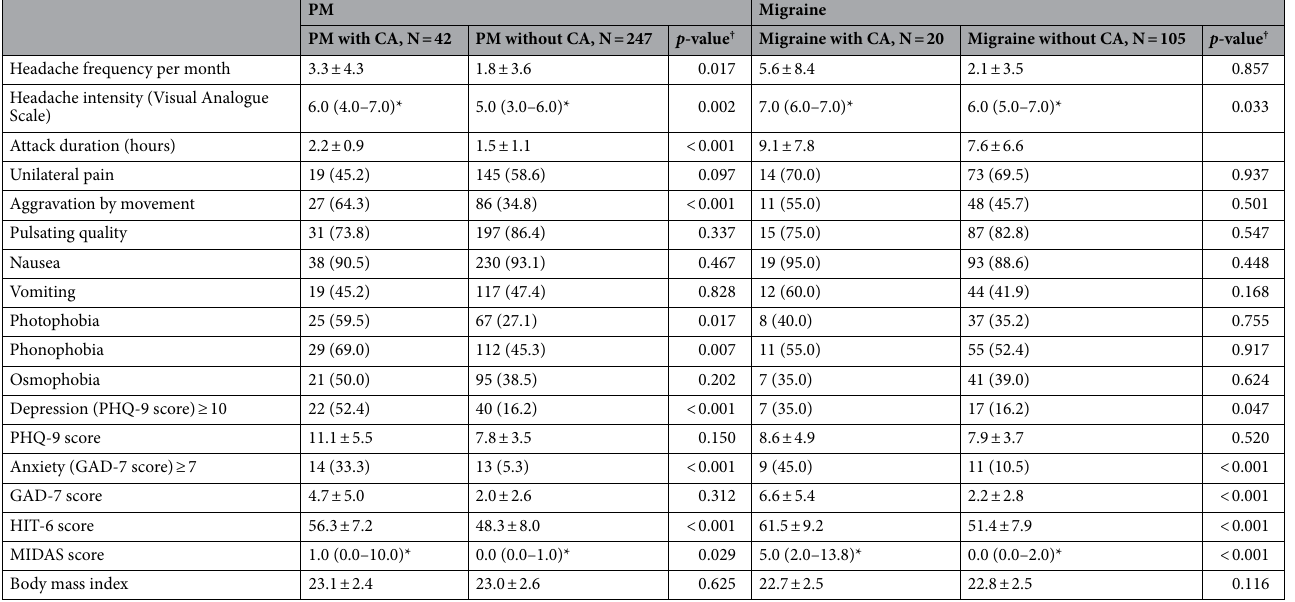
Table 3. Clinical characteristics of probable migraine and migraine according to the presence of cutaneous allodynia. PM: probable migraine, CA: cutaneous allodynia, MIDAS: migraine disability assessment, HIT-6: Headache Impact Test-6, PHQ-9: Patient Health Questionnaire-9, GAD-7: Generalized Anxiety Disorder-7. *Median and interquartile range. † Compared using linear regression analyses with age and sex (year, continuous) adjustment.